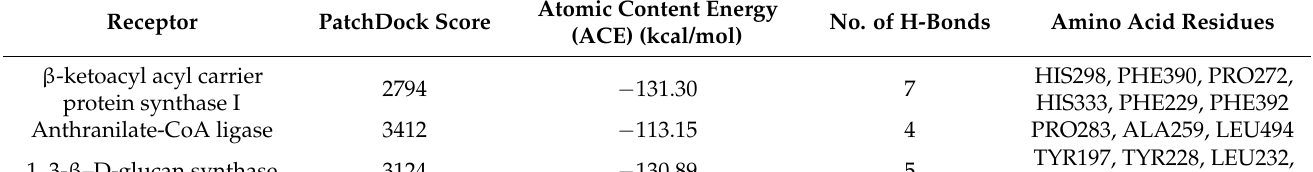
Table 3. The docking interaction parameters of Fenchone with three proteins.